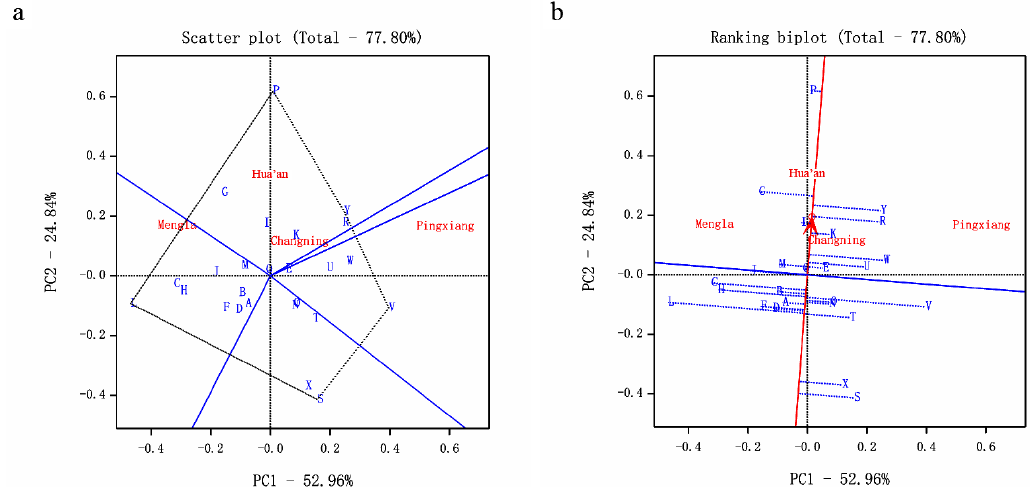
Figure 2. Biplot analysis based on the height of 25 provenances. ( a ) Polygon view of GGE biplot—which is best for